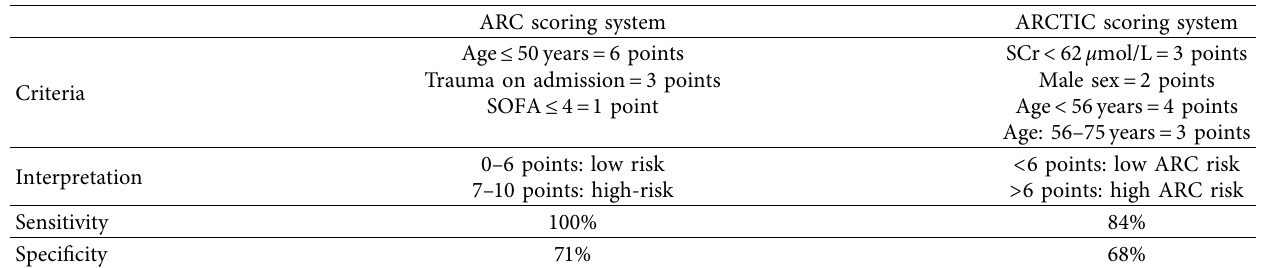
Figure 2: Potential contributing factors to ARC. ANP: atrial natriuretic peptide, ARC: augmented renal clearance, BNP: brain natriuretic peptide. Modifed from Cook AM [1]. Table 2: Te ARC risk scoring systems. Modifed from Hobbs et al. [3] and Baptista et al.